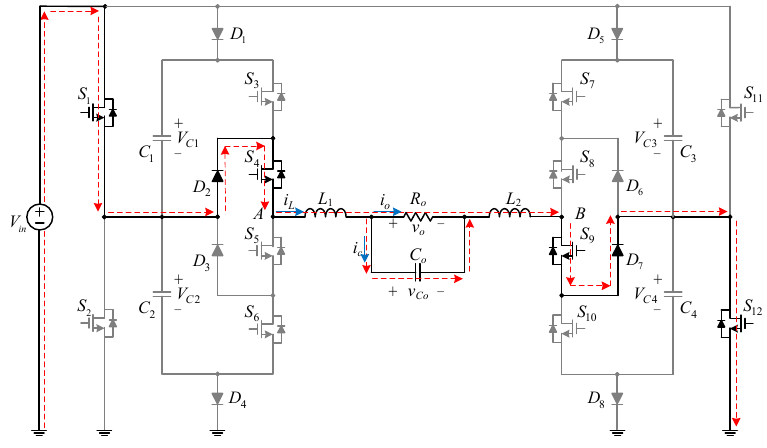
Figure 5. Current flow direction of stage I when switch S 1 is on. Interval [ t 1 ≤ t ≤ t 2 ] : The switches S 1 , S 3 and S 10 are all off. At the same time, the input voltage is disconnected from the output. As shown in Figure 6, the current flowing through the inductors L 1 and L 2 will form a circuit loop from the switches S 4 , S 9 , S 12 to the diodes D 2 , D 7 and the body diode of the switch S 2 , so the voltage across the terminals A and B is v AB = 0 (2)